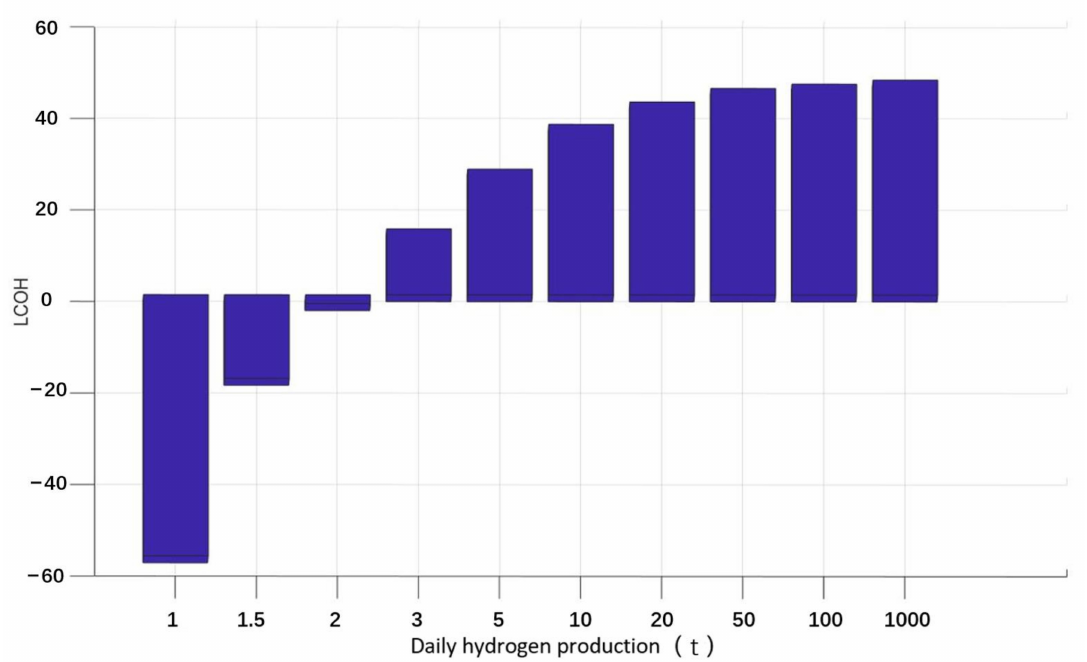
Figure 5. Case study for Anhui province (analysis method focusing on plant with LCOH as optimi‑ sation